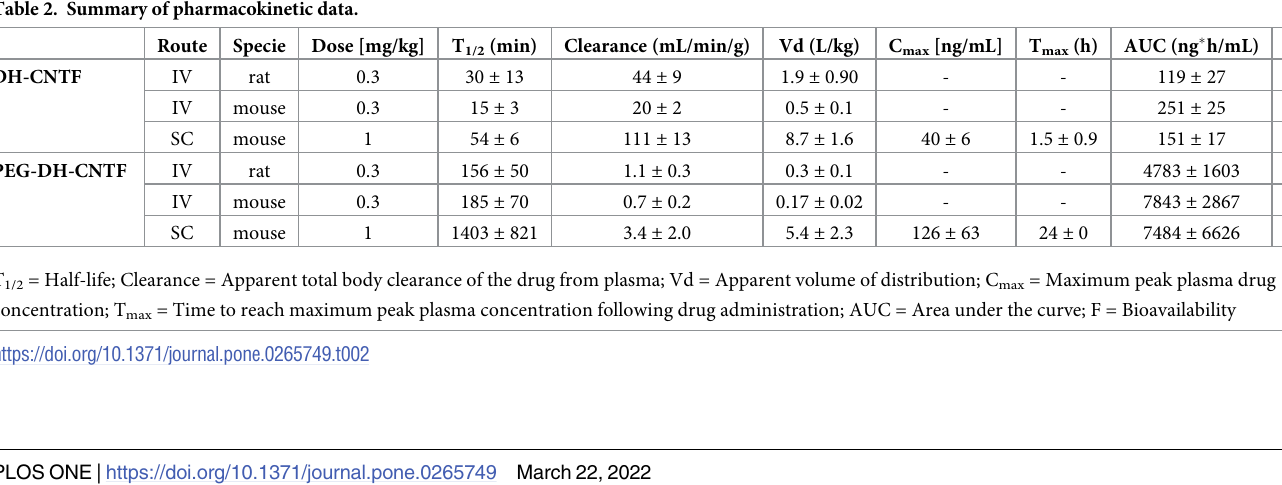
improved both the profile of blood glucose (Fig 10) and the area under the curve, AUC (Table 5).